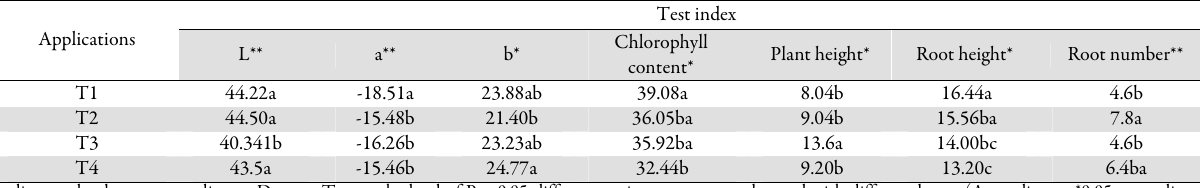
Table 1. The effects of lighting applications in wavelength on morphological and physiological properties of stevia